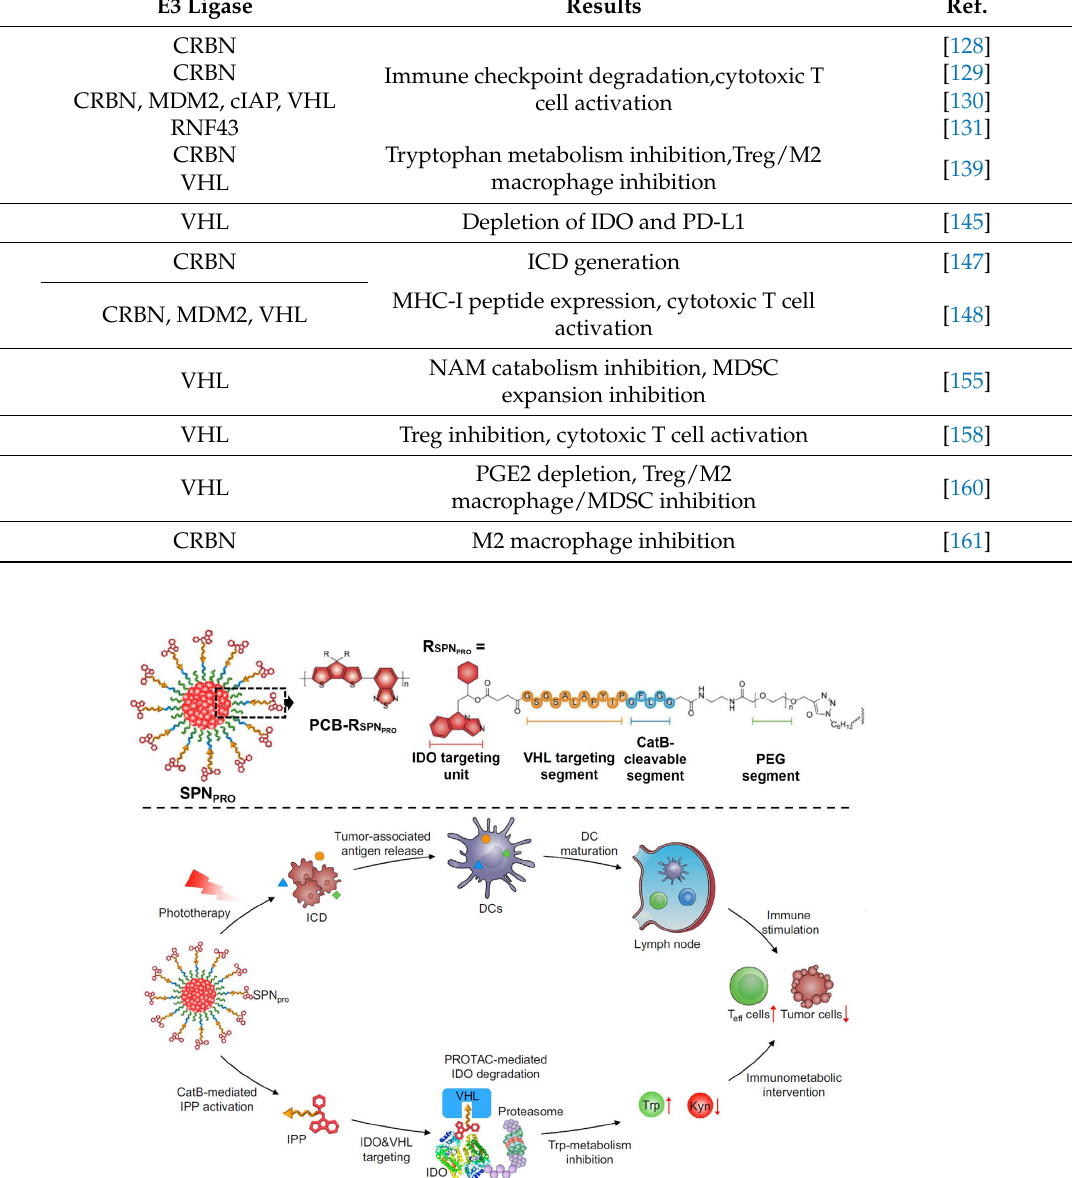
Table 2. Research cases of PROTAC application for cancer immunotherapy. Results Ref.